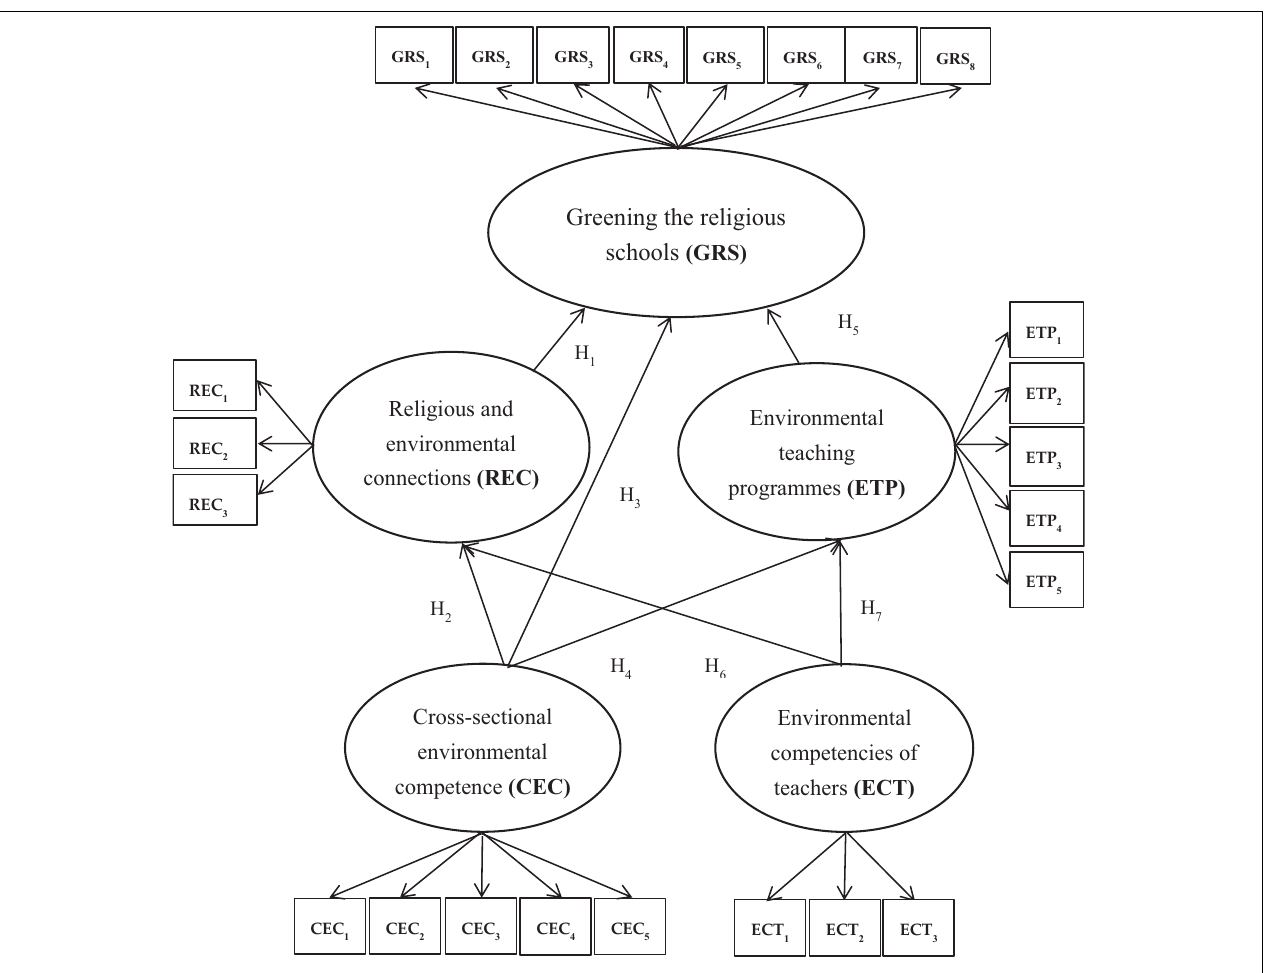
FIGURE 1 | Conceptual